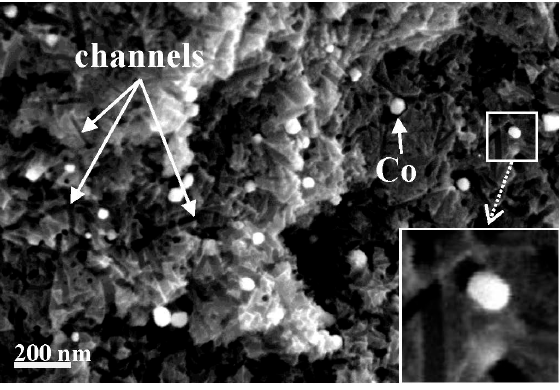
Figure 19. SEM image of Co-ACF and FESEM image of its cross-section surface (before removal of cobalt nanoparticles. Inset: amplification). Reproduced from [137] with permission from Elsevier © 2014.